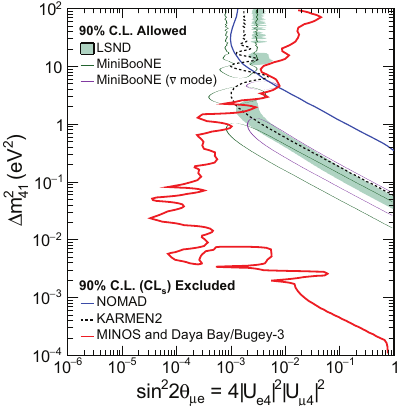
Figure 6. Exclusion contour obtained in the DANSS experiment [13]. The shaded areas show the 90% CL (cyan) and 95% CL (dark cyan) ex- cluded regions. Curves show the allowed regions from reactor disappearance experiments. The star shows the best-fit point from the reactor and gal- lium